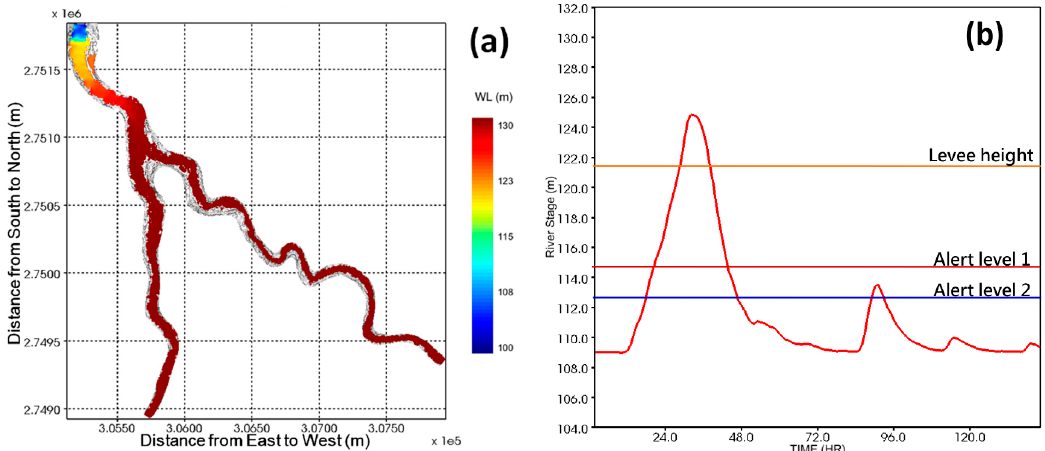
Figure 9. Hindcasting of the highest water level distribution ( a ) and river stage time series at the Lansheng Bridge ( b ) during Typhoon Soudelor (2015).